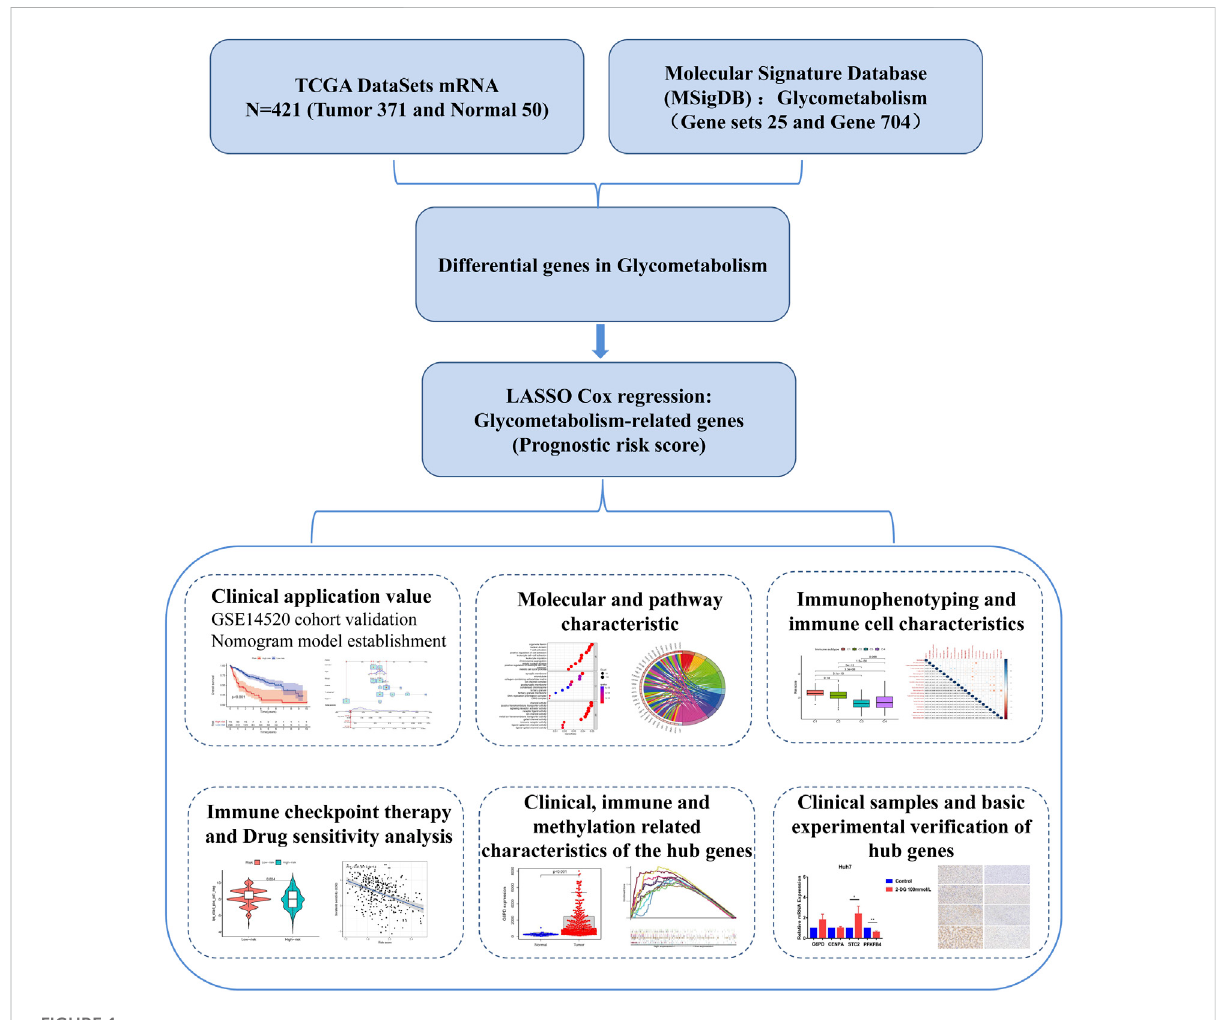
FIGURE 1 Construction and characterization of glycometabolism-related risk